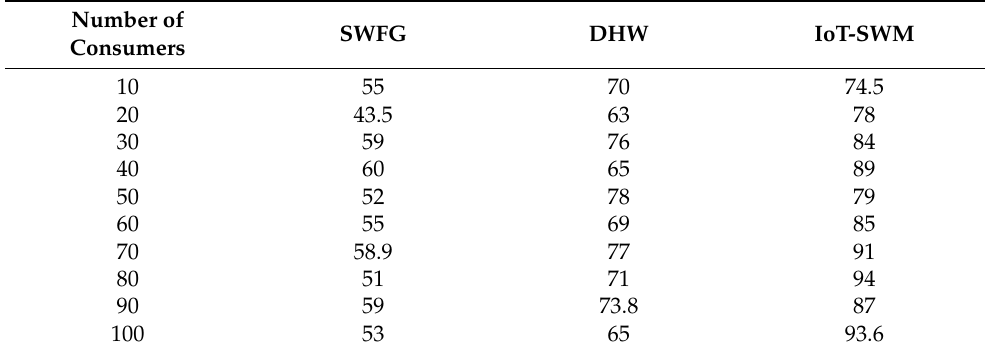
Table 3. Analyzing water demand